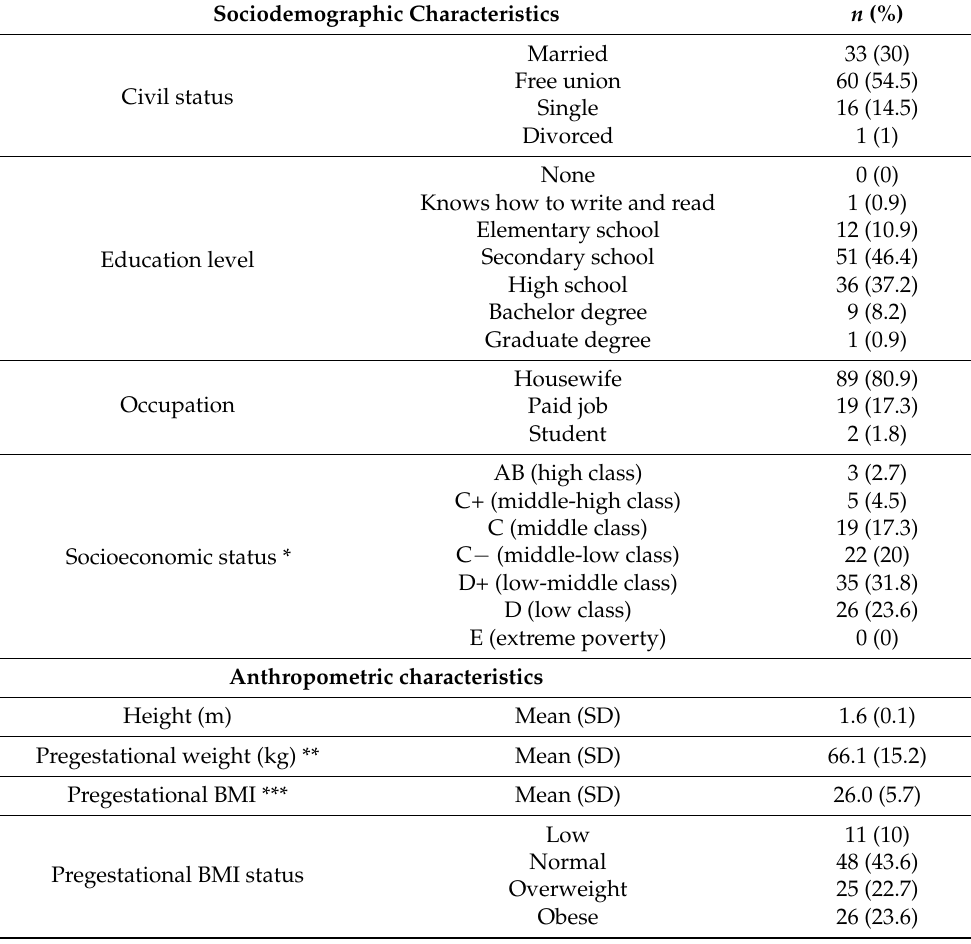
Table 1. Participants’ sociodemographic, anthropometric characteristics and iron status ( n = 110). Sociodemographic